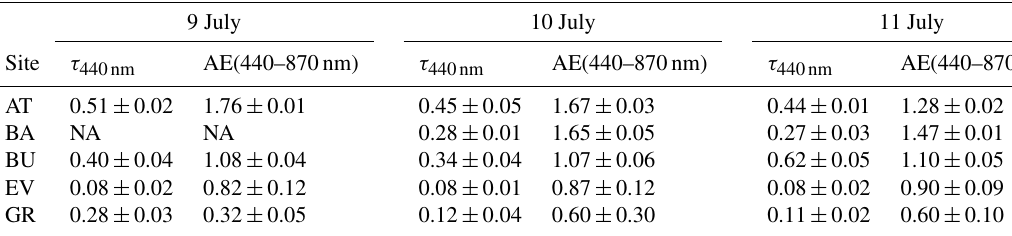
Table 3. τ 440nm and AE(440–870nm) daily mean values ( ± standard deviation) at the five stations on 9, 10, and 11 July 2012.